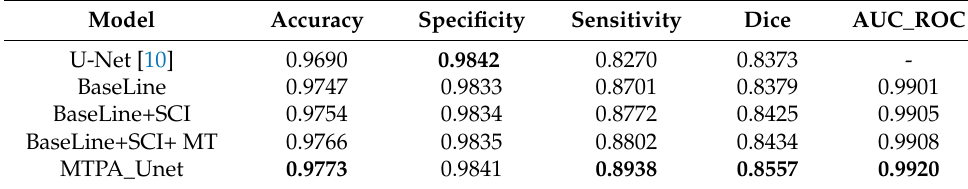
Table 4. Ablation experiments on the STARE